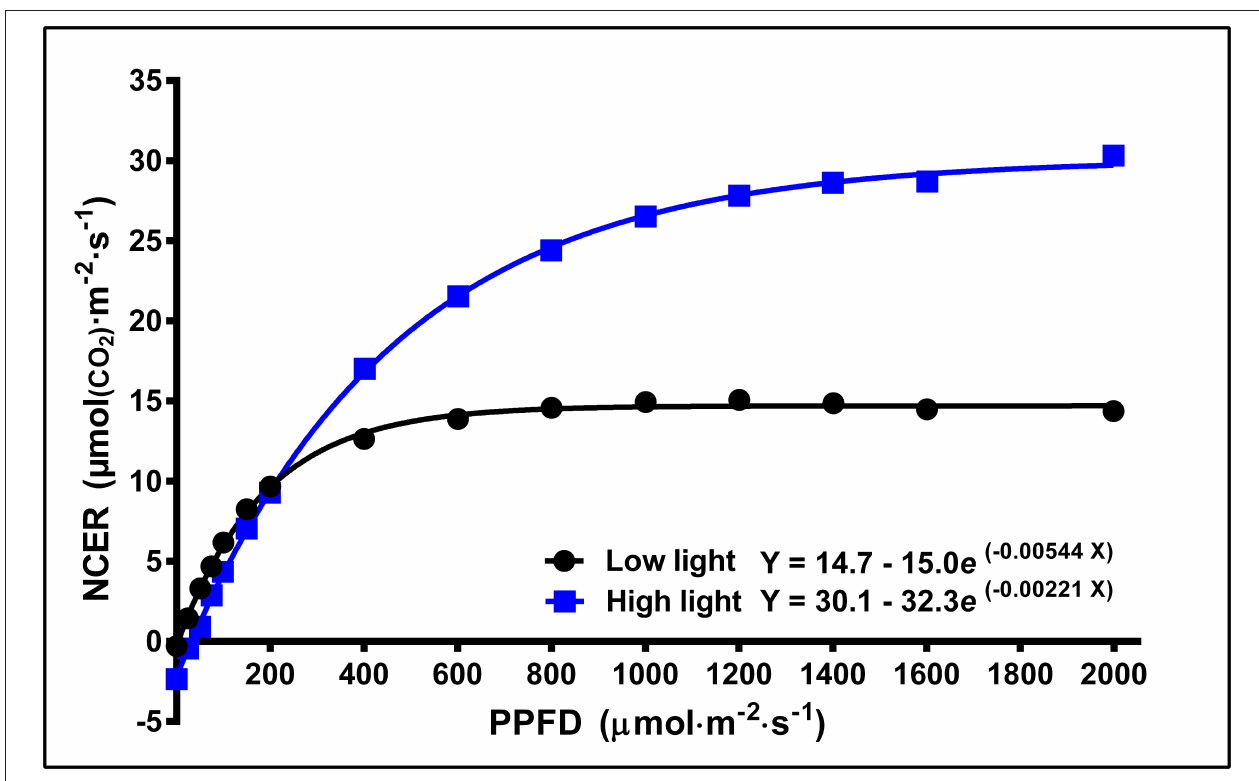
FIGURE 3 | Typical light response curves [net CO 2 exchange rate (NCER) response to light intensity] of the youngest fully-expanded fan leaves of Cannabis sativa ‘Stillwater’ grown under either low or high localized photosynthetic photon flux densities (LPPFD). The low and high LPPFD were 91 and 1,238 µ mol · m − 2 · s − 1 , respectively. Measurements were made during week 5 after the initiation of the 12-h